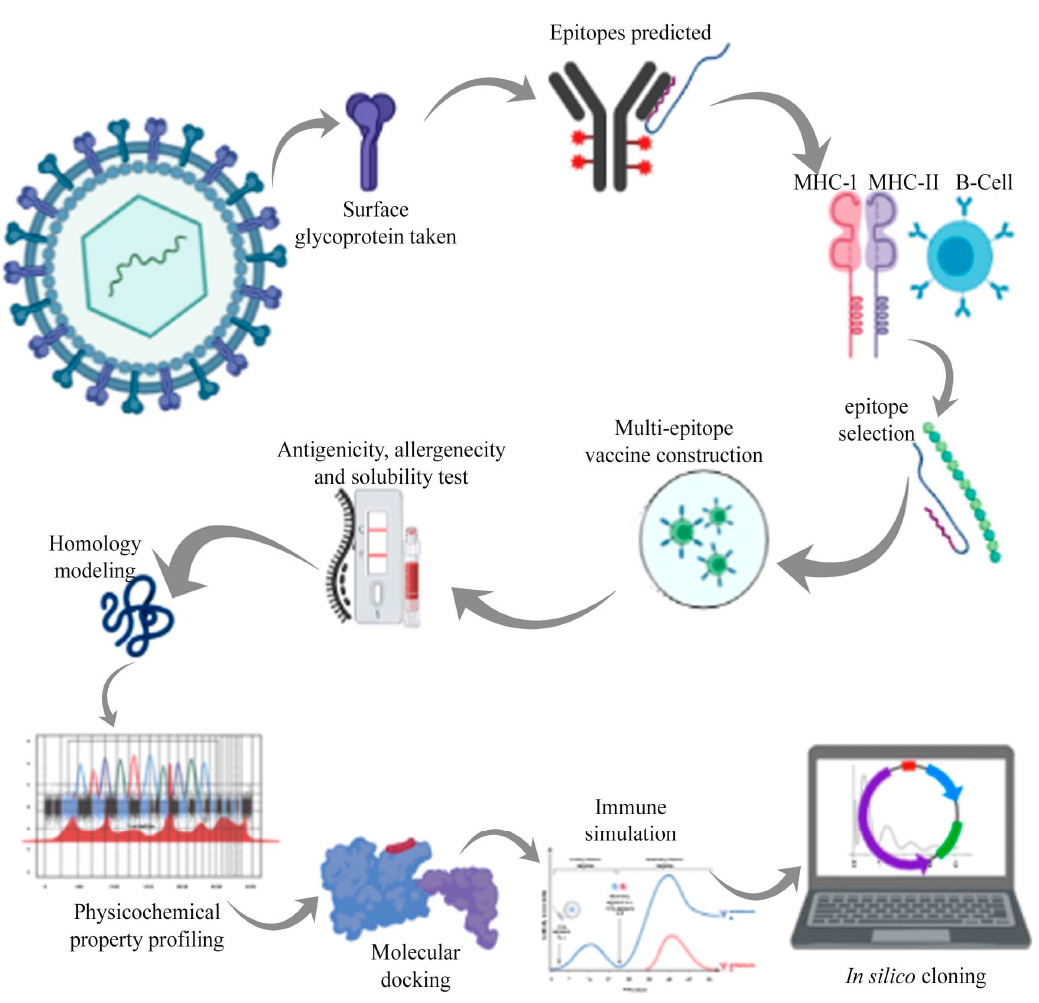
Figure 2. Schematic workflow followed for the multi-epitope vaccine design.